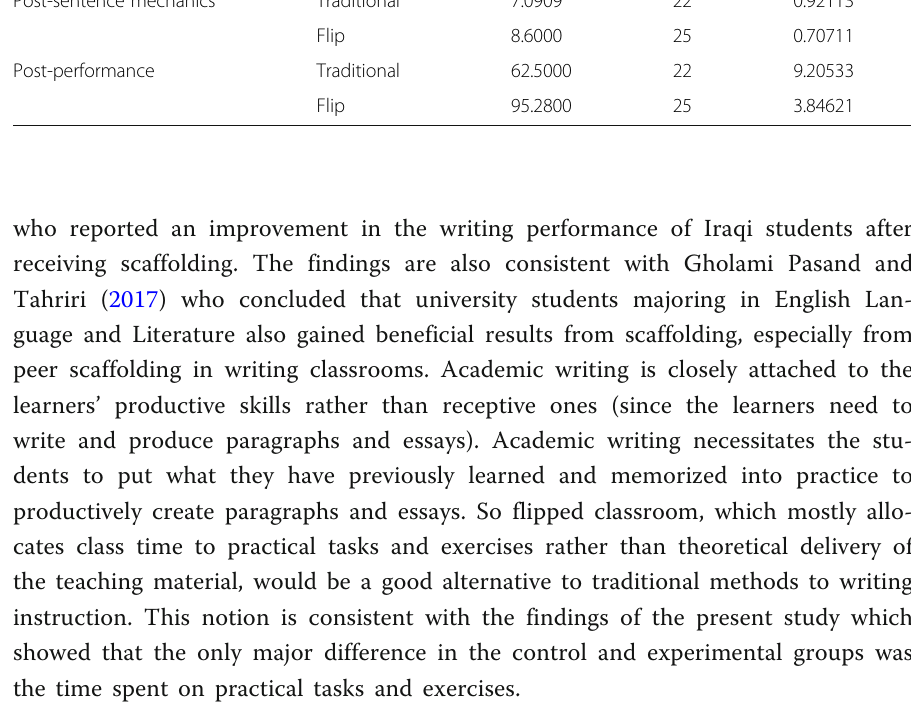
Table 4 Mann-Whitney test